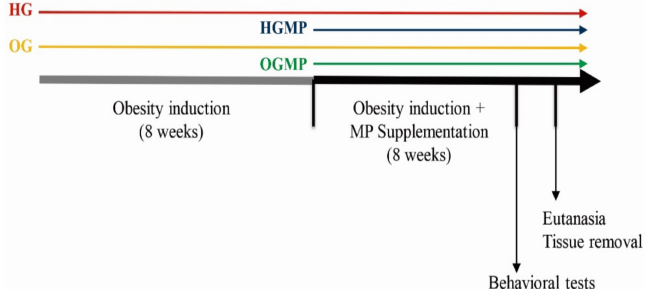
Figure 7. The study design timeline and steps of the biological assay. HG = healthy group; OG = obese group; HGMP = Healthy group with MP administration; OGMP = Obese group with MP